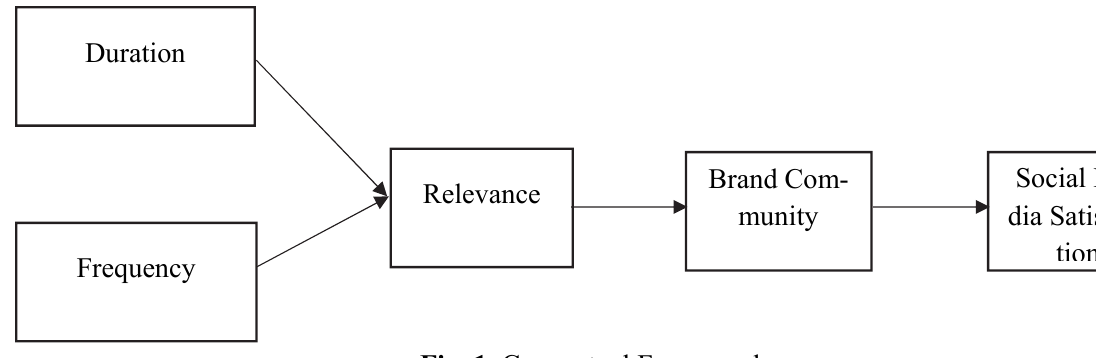
Fig. 1. Conceptual